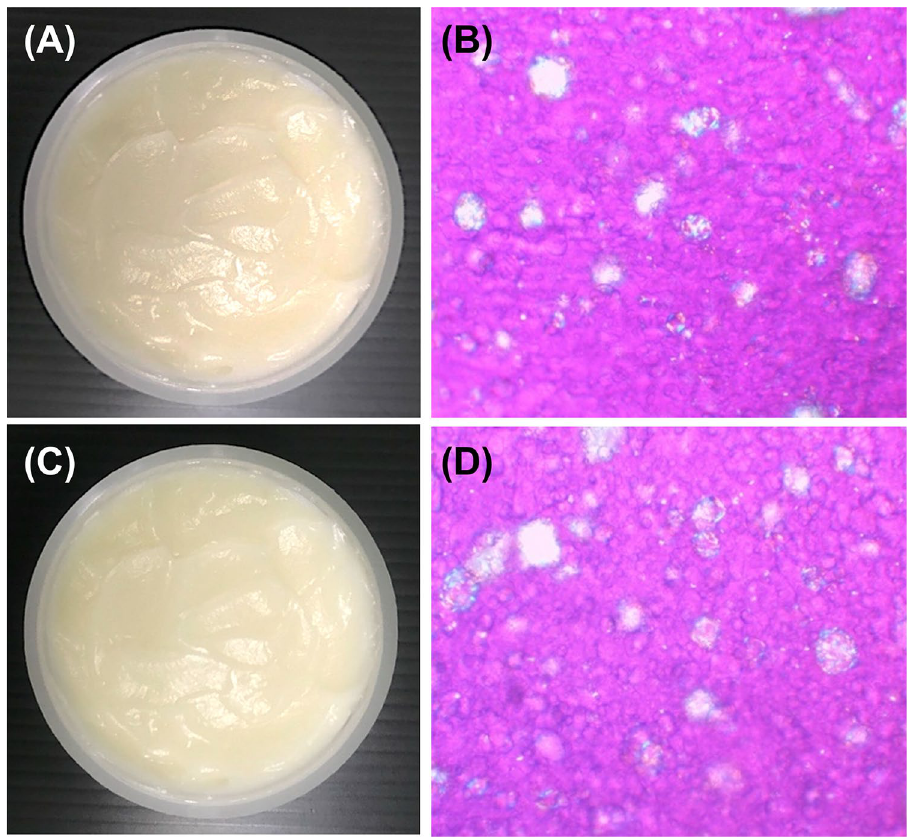
Figure 8. Physical appearance and photo taken under polarized light optical microscope (magnification 10×) of lamellar liquid crystal formulation containing D. longan seed ethyl acetate extract (LLC-EtOAc) before ( A ) and after eight heating–cooling cycles to test stability ( B